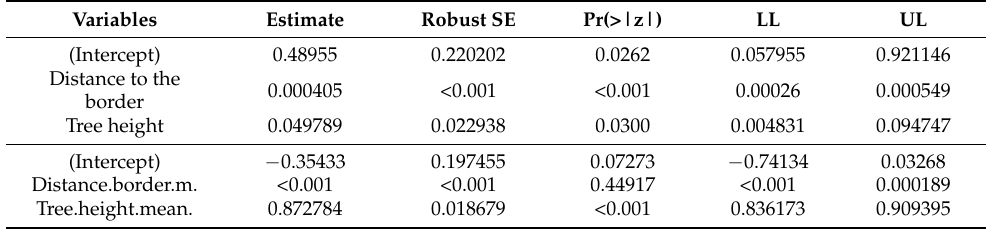
Figure 3. Regression between number of nests and mean tree height. (left) Nest height = −0.315 + 0.878 × mean tree height; R 2 = 0.97, and number of nests and mean distance to the city border. (right) Nest height = 6.601 + 0.002 × distance to the border; R 2 = 0.21. Table 1. Results of GLM accounting for number of nest and mean nest height in each (1 × 1 km) square in the city of Gorz ó w Wlkp. in relation to the distance from the external border of the urban area and the average tree height. Confidence intervals for number of the nest: LL = lower level. UL = upper level. AIC: 132.28. AIC of the best model: 487.84. Confidence intervals for mean nest height: LL = lower level. UL = upper level. AIC of the best model: